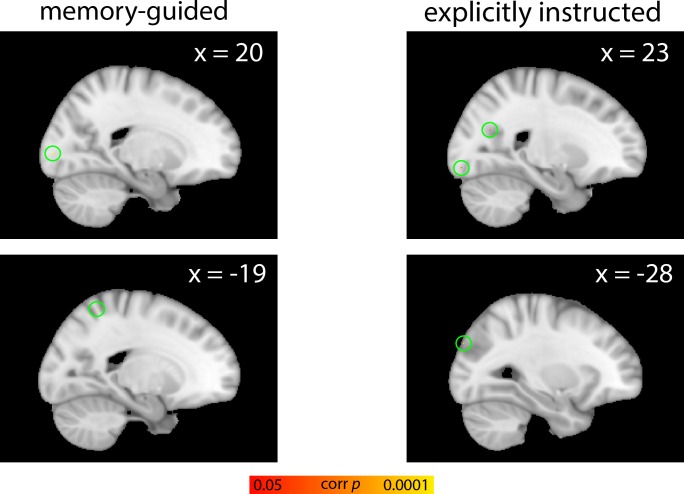
Whole-brain searchlight analysis of preparatory attentional states during the orienting period.Results are shown for the memory-guided (left panel) and explicitly instructed (right panel) tasks. Only a few isolated voxels reached significance using family-wise error rate correction (p<0.05). Significant voxels are circled in green to aid their detection. No voxels survived correction for multiple comparisons in the contrast memory-guided > explicitly instructed attention.